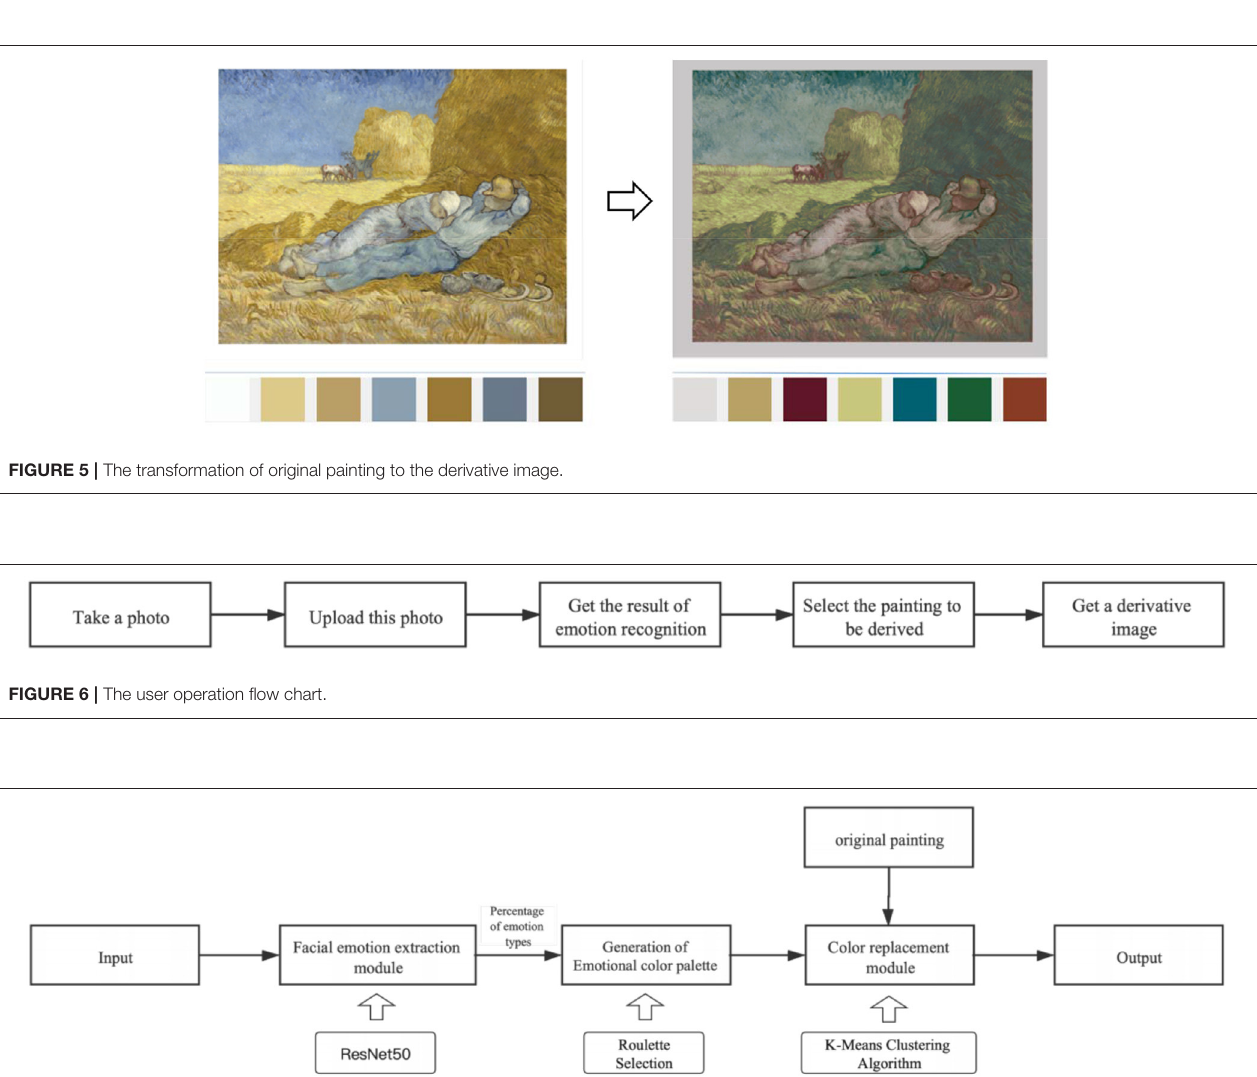
FIGURE 7 | The System flow